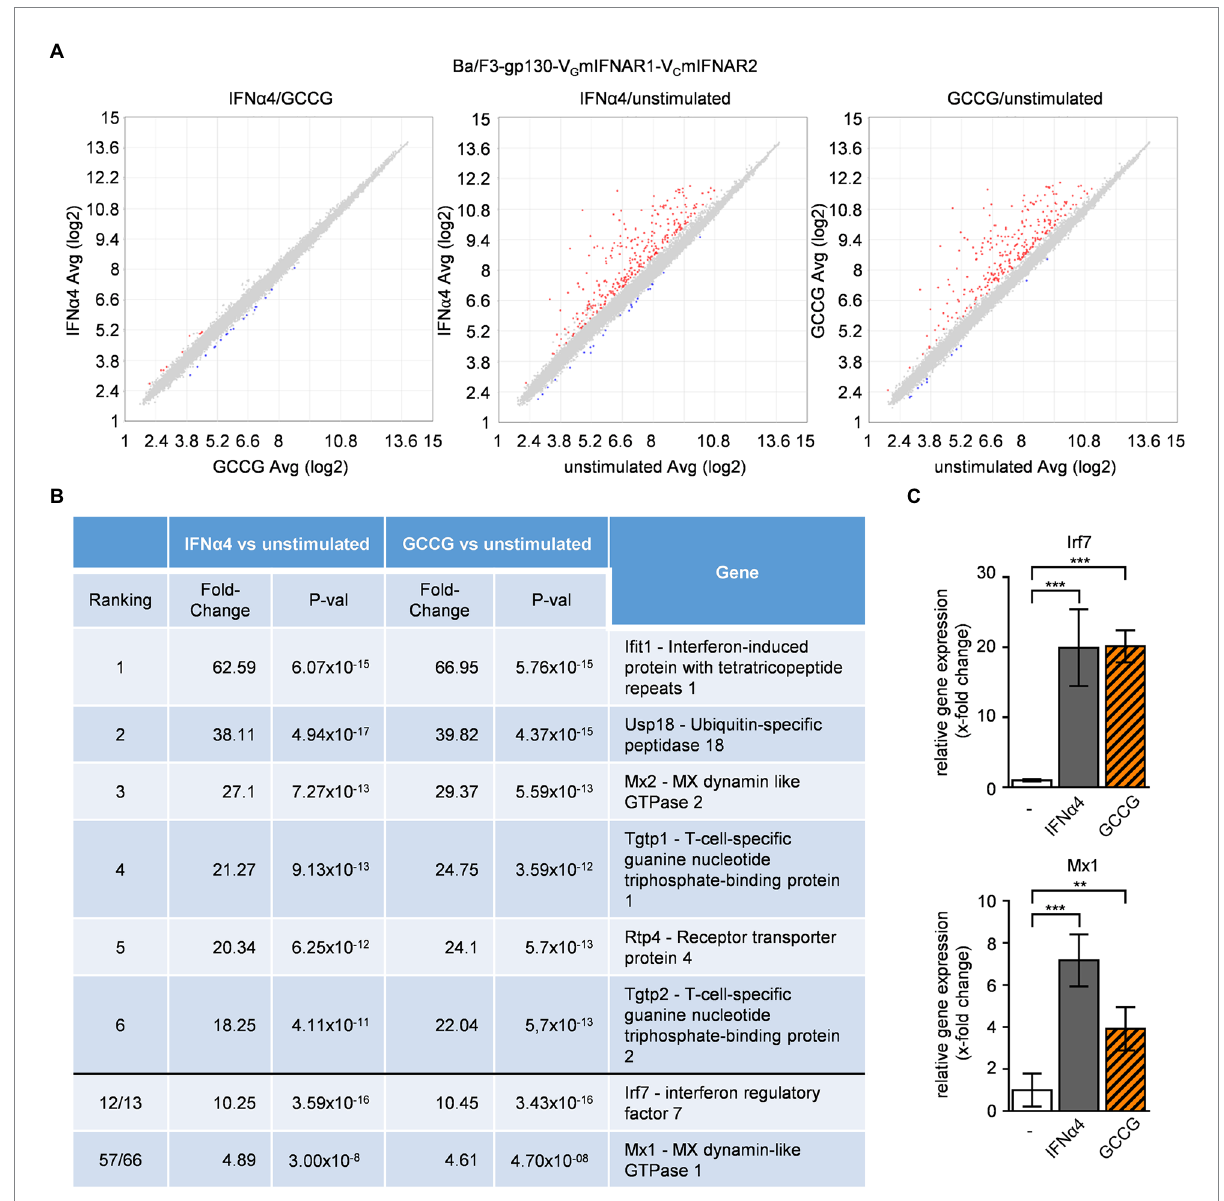
FIGURE 4 Comparable gene regulation pattern by native and synthetic type I IFN receptors. Microarray analysis of Ba/F3-gp130-V G mIFNAR1-V C mIFNAR2 cells either stimulated with IFN α 4 or GCCG. The comparison was performed with 1.5-fold ( p -value < 0.05). Varying upregulated genes are shown in red, downregulated genes in blue. (A) Scatter blot comparing mRNA levels of IFN α 4 (200 U/ml) and GCCG (100 ng/ml) stimulation of Ba/F3- gp130-V G mIFNAR1-V C mIFNAR2 cells; left: IFN α 4 vs. GCCG, middle: IFN α 4 vs. unstimulated, right: GCCG vs. unstimulated. Cells were stimulated for 240 min. (B) List of regulated mRNAs for IFN α 4 or GCCG stimulation with respective fold change and p-value. (C) Verification of microarray data by quantification of mRNA expression of two genes (Irf7, Mx1) for IFN α 4 or GCCG stimulation of Ba/F3-gp130-V G mIFNAR1-V C mIFNAR2 cells. Mean value of four independent experiments is shown. ** p ≤ 0.01; *** p ≤